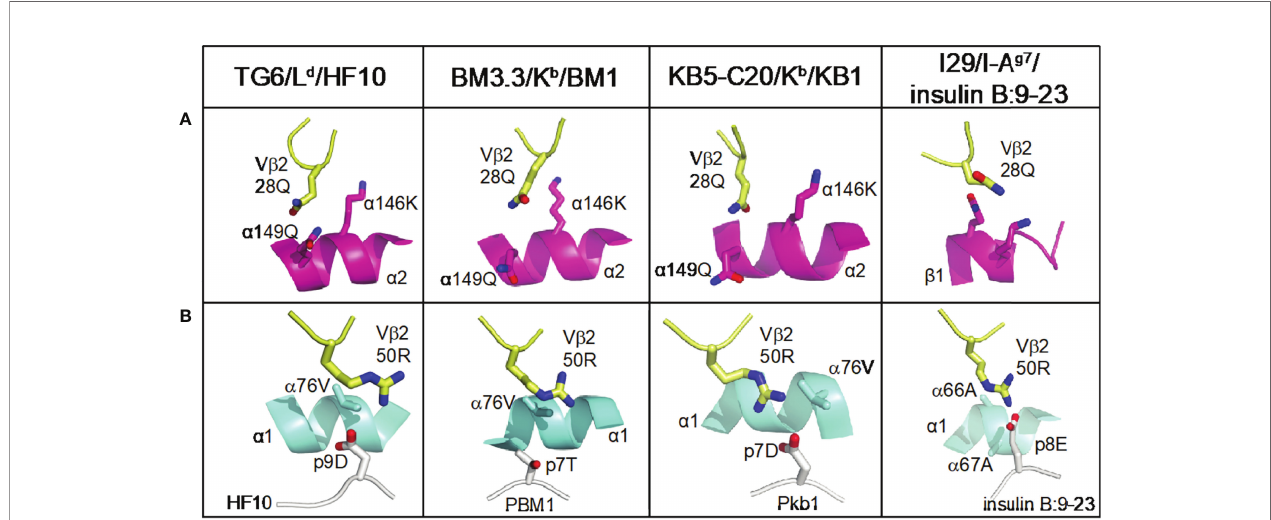
FIGURE 6 | Conserved germline contacts of V b 2 with pMHC. All V b 2 TCR/pMHC structures are superposed and presented in the same view. Atoms are shown in CPK coloring. V b 2 residues (28Q and 50R) are shown as pale yellow sticks. (A) The position of V b 2 28Q from V b 2 containing TCRs is shown interacting with the MHC a 2 helices (or b 1 helix from MHC-II) shown in magenta ribbon diagram. (B) The position of V b 2 50R with pMHC contact from the same structures as in (A) . MHC a 1 helices are shown in cyan ribbon diagram, peptides are shown in white cartoon, and the residues that interact with TCR are shown as white sticks. Protein Data Bank identi fi ers are: L d -HF10 (PDB: 6X31); BM3.3 TCR with K b -pBM1 (PDB: 1FO0); KB5 TCR with K b -Pkb1 (PDB: 1JK2); I29 with IA g7 -insulin B:9-23 (PDB: